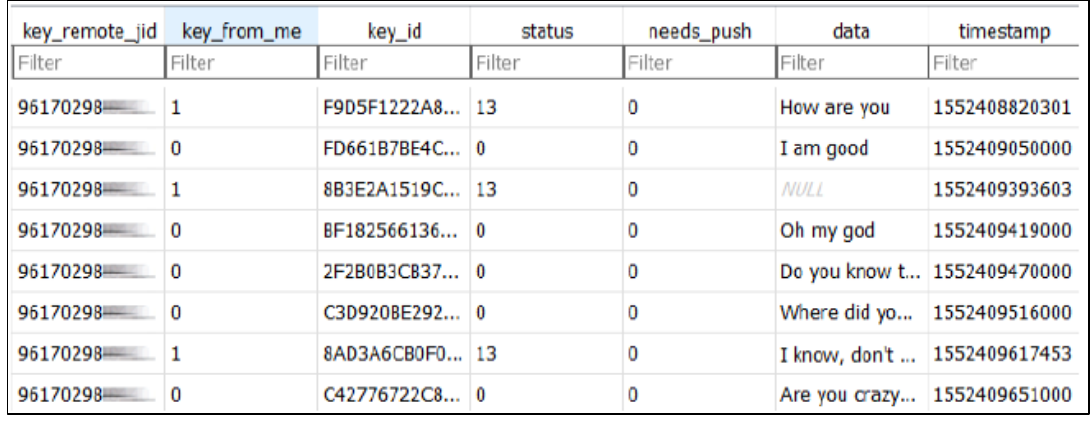
Figure 13. Reconstruction of the chat